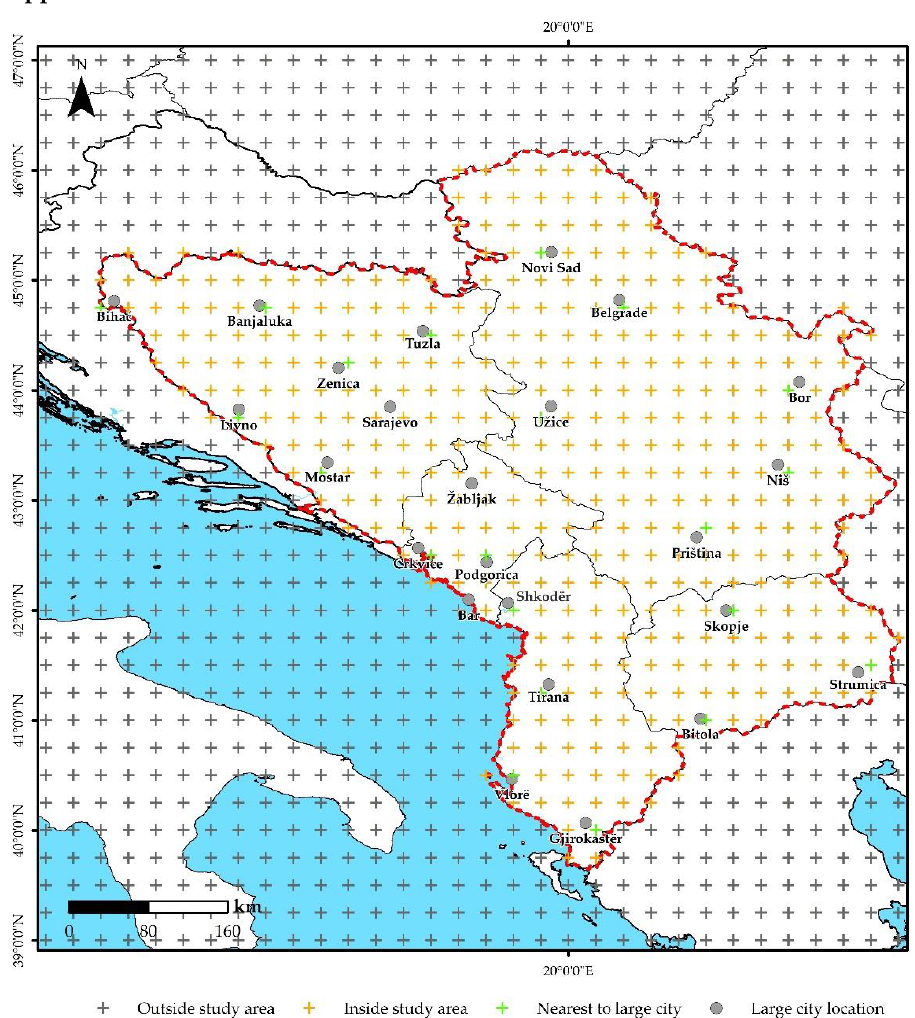
Figure A1. Position of gridded data outside (grey colour) and inside study area (orange colour), and position of the grid nearest to the large city (lawn green colour).